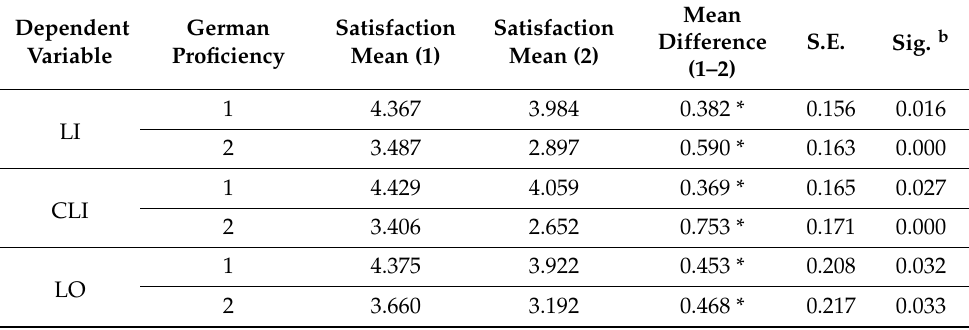
Table 3. MANOVA test for